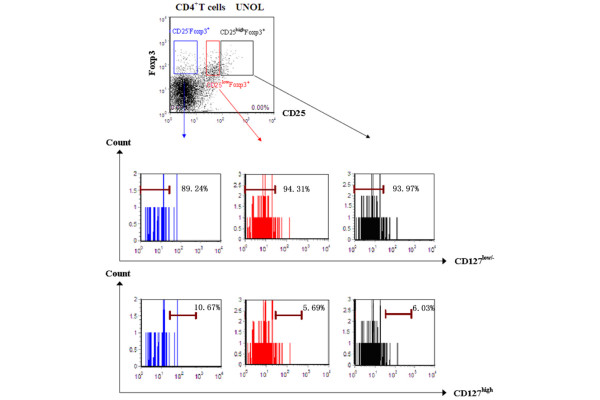
Expressions of CD127 on CD25high, CD25low, and CD25- subpopulations of CD4+ Foxp3+ T cells from patients with untreated new-onset lupus (UNOL).